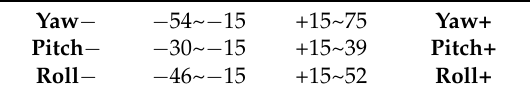
Figure 3. The geometric model for the eye.